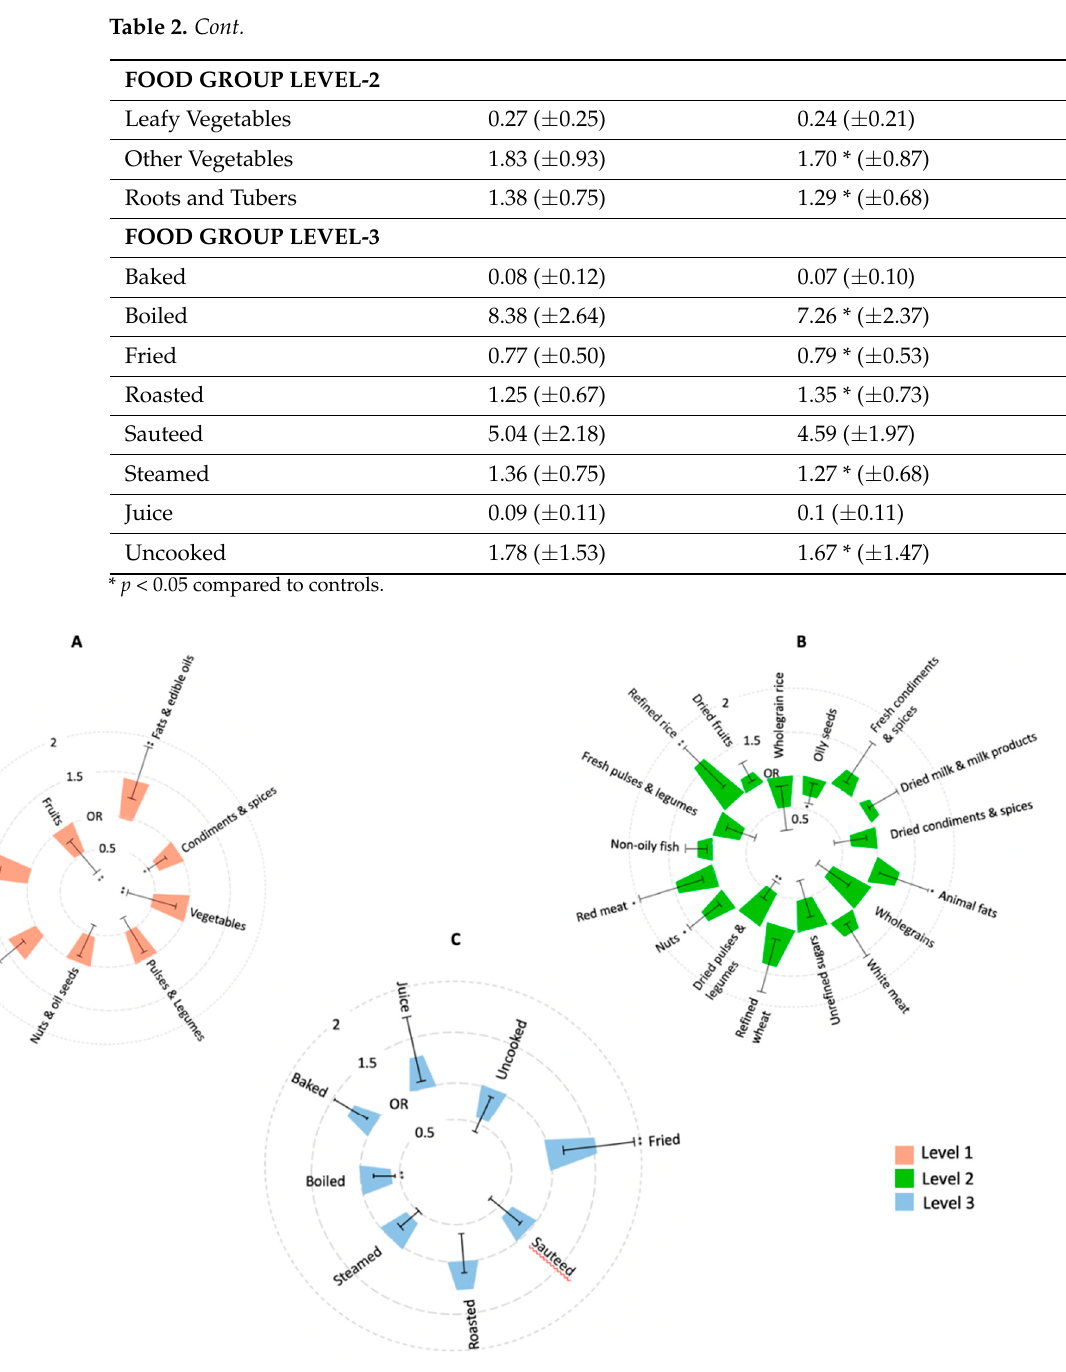
Figure 2. CIRCOS plot showing the association of individual food group levels ( A -Level 1; B -Level 2; C -Level 3) with NAFLD status. Bars represent Odds ratio’s (ranging from 0.5–2) and 95% CIs from logistic regressions of unadjusted intakes, adjusted for age, gender and weight. (* p < 0.05; ** p < 0.001).